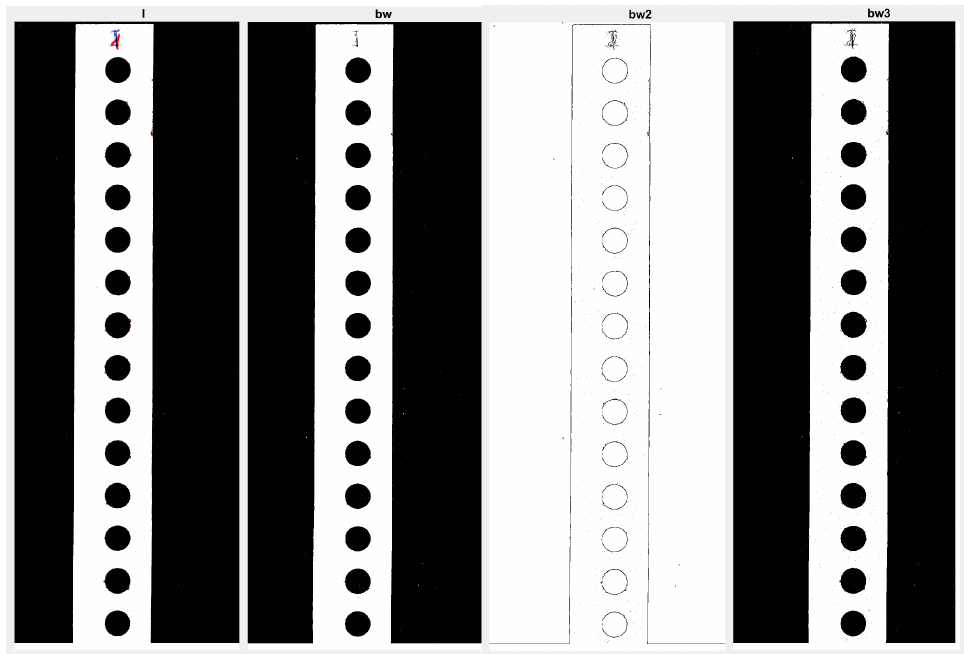
Figure 5. Steps of profile segmentation ( left to right ): input scan, “bw”, “bw2”, “bw” +